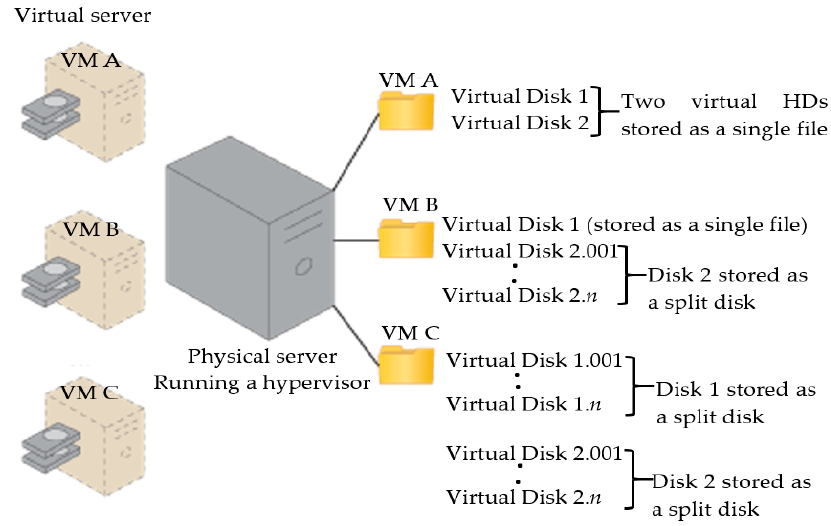
Figure 8. Virtual disk technique.